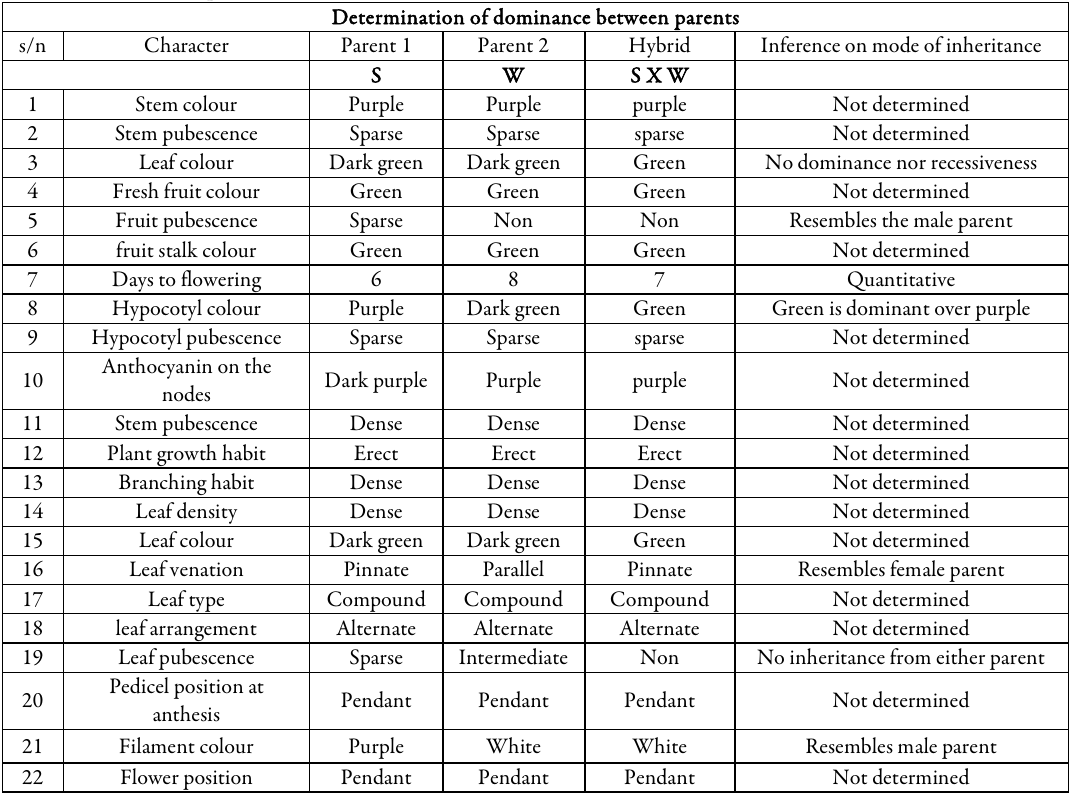
Table 12. Comparison of S and